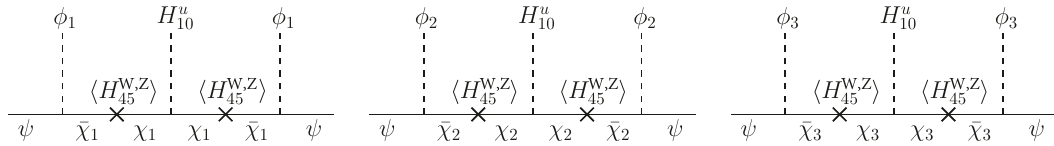
Table 2. Fields that appear only at high energies. Together with the ones in table 1 they list the complete (cid:12)eld content of the model.